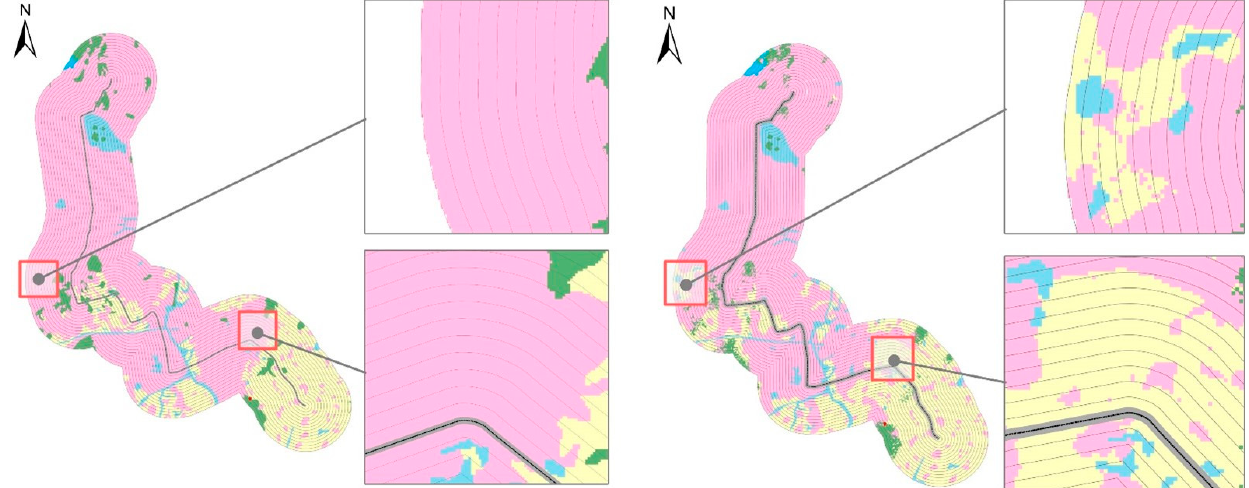
Figure 12. Comparison of the simulated results with different buffer zones in 2005: left: actual map, right: our result.